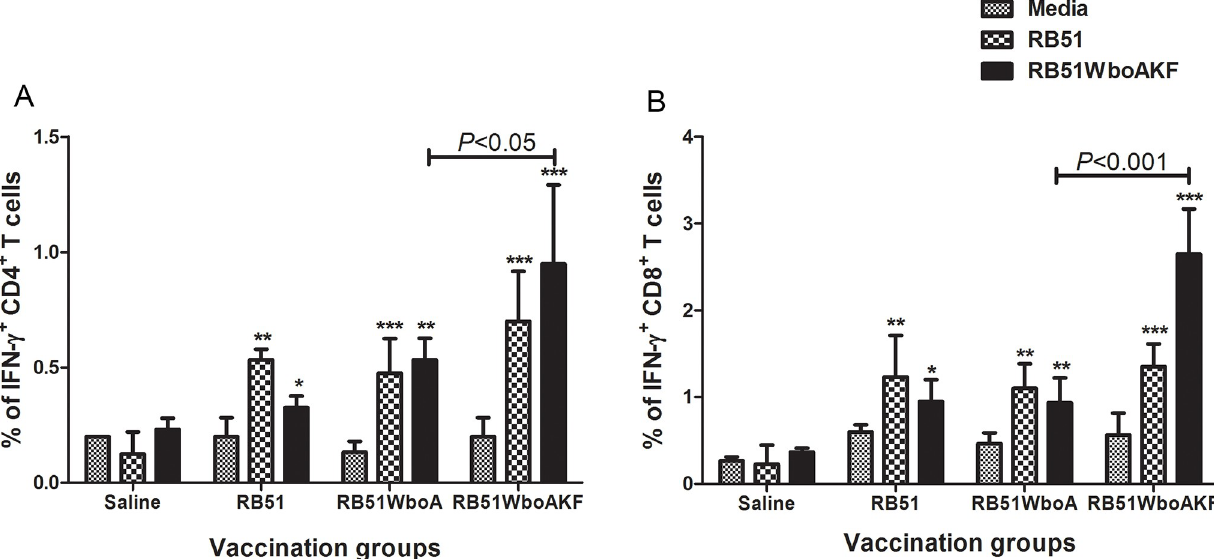
Fig 9. Flow cytometric analysis showing the percentage of interferon- γ secreting (A) CD4 + and (B) CD8 + T cells in the spleens of immunized mice. Mice were immunized intra-peritoneally with 10 8 CFU of RB51, RB51WboA, RB51WboAKF, or inoculated with saline. Their splenocytes were harvested and stimulated in vitro with media (unstimulated), heat-killed RB51 or RB51WboAKF. Values are shown as mean ± standard deviation (n = 4). Asterisks indicate statistically significant differences from the corresponding unstimulated control. � , P < 0.05; �� , P < 0.01; ��� , P < 0.001.